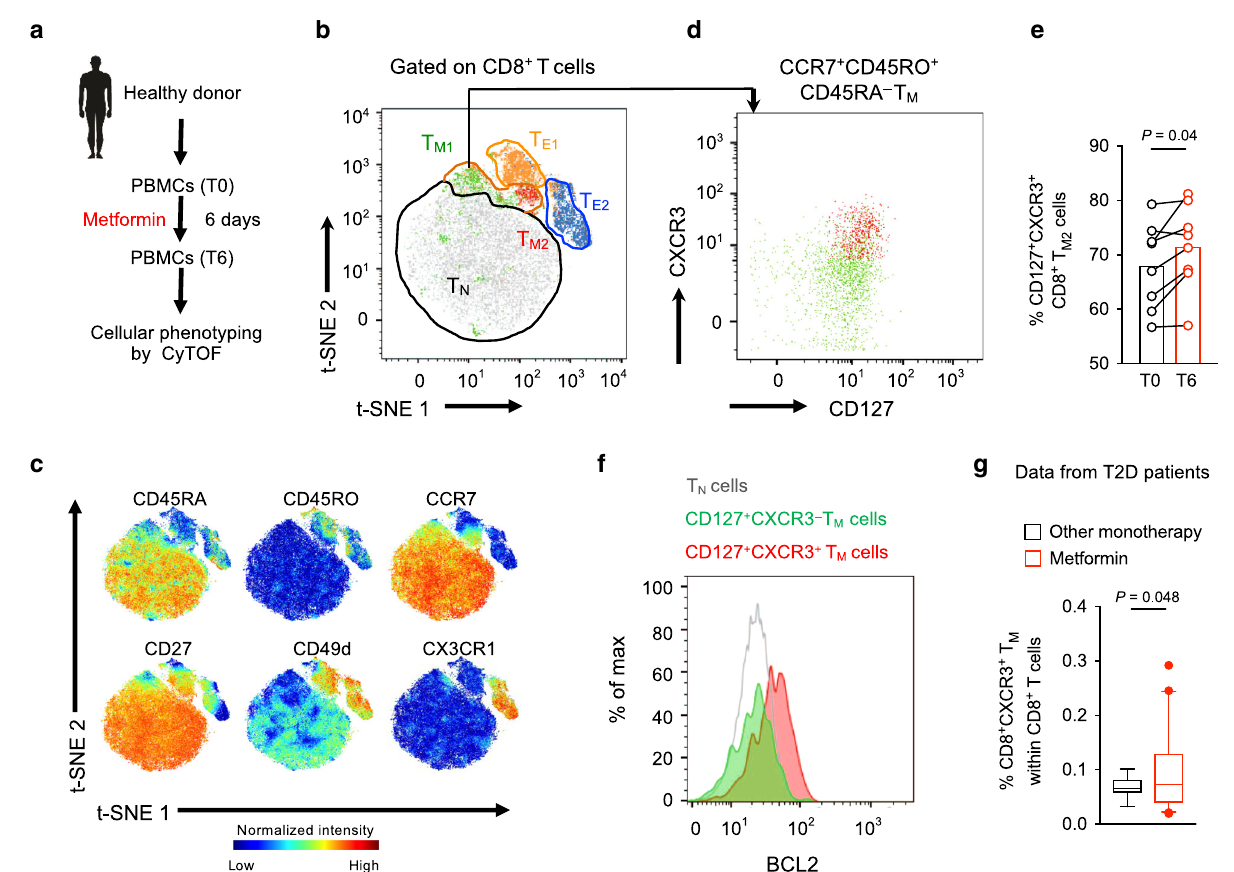
Fig. 6 Metformin treatment expands CD8 + CXCR3 + T M cell population in humans. a Strategy of analyzing PBMCs from metformin-treated healthy individuals. b t-SNE map of human peripheral CD8 + T cells with manually cluster gating for T E , T M , and T N cells. c Normalized expression intensities of indicated markers were calculated and overlaid on the t-SNE plot, characterizing all cluster of human CD8 + T cells. d Manual gating identi fi ed differential expression of CD127 and CXCR3, distinguishing two CD8 + T M subpopulations, T M1 and T M2 . e Frequency of CD8 + CD127 + CXCR3 + T M cells before and after metformin treatment. n = 8 subjects, analysis by Wilcoxon matched-pairs signed rank test. f Overlay plot showing expression of BCL2 in CD8 + CD127 + CXCR3 - and CD8 + CD127 + CXCR3 + T M cells. BCL2 expression in CD8 + T N cells is also indicated. Data shown from one representative donor. g Flow cytometric analysis of frequency of peripheral CD8 + CXCR3 + T M cells in T2D patients receiving either metformin or other diabetic monotherapy, n = 18 other monotherapy group, n = 42 metformin group. Box-and-whisker plot show the median, 5 and 95 percentiles. Analysis by two-tailed t test with Welch ’ s correction.